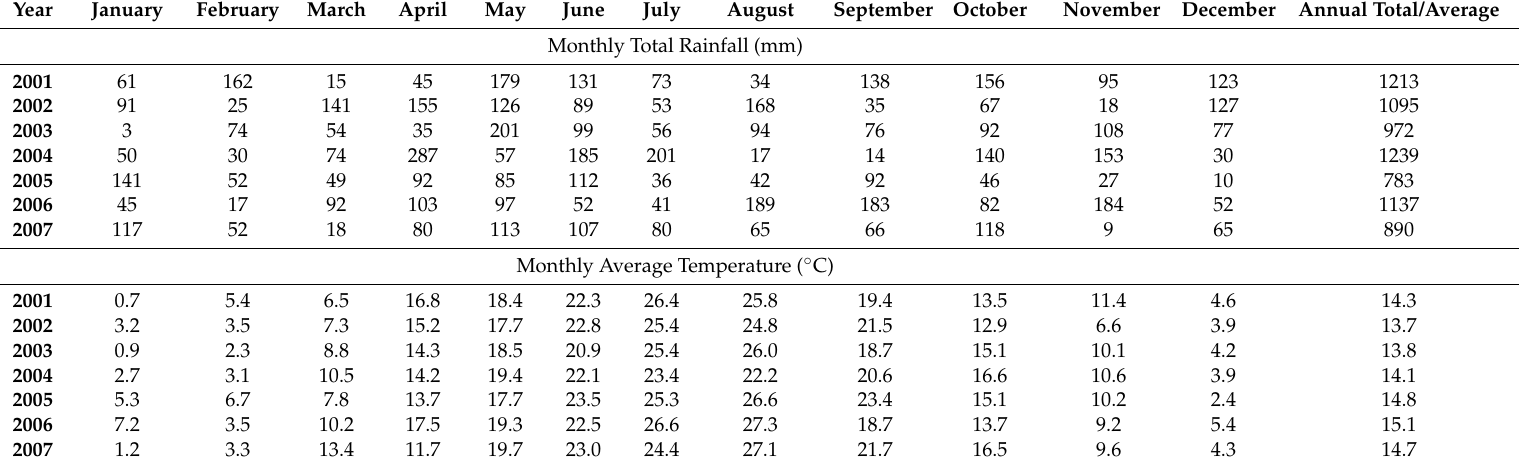
Table 4. Monthly total rainfall and average temperature at Fayetteville, AR from 2001 to 2007.